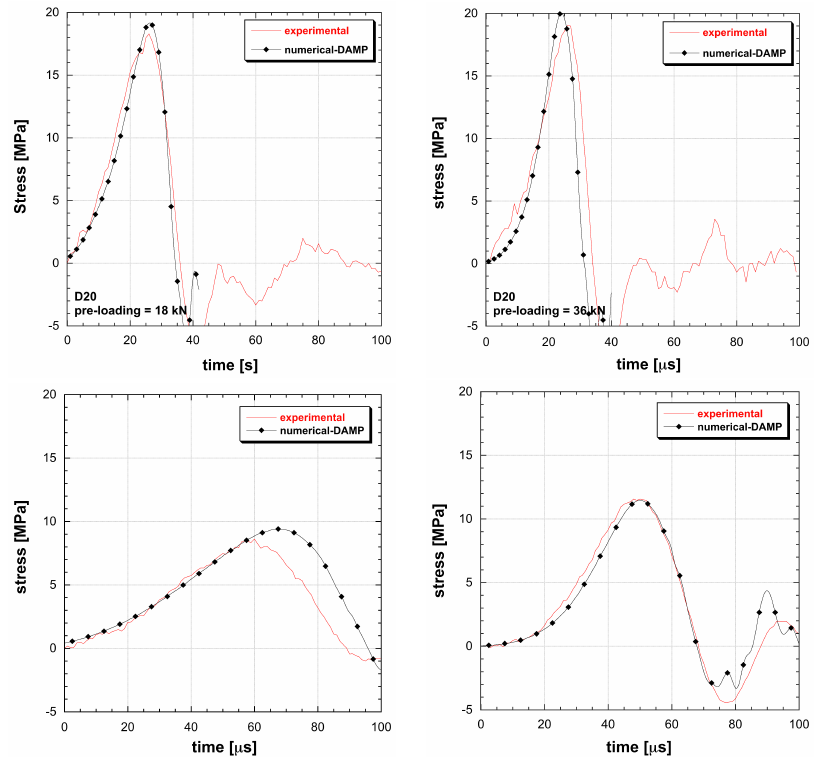
Figure 7. Comparison between experimental and simulated behaviour of UHPC in tension at different loading rate and size (DAMP material